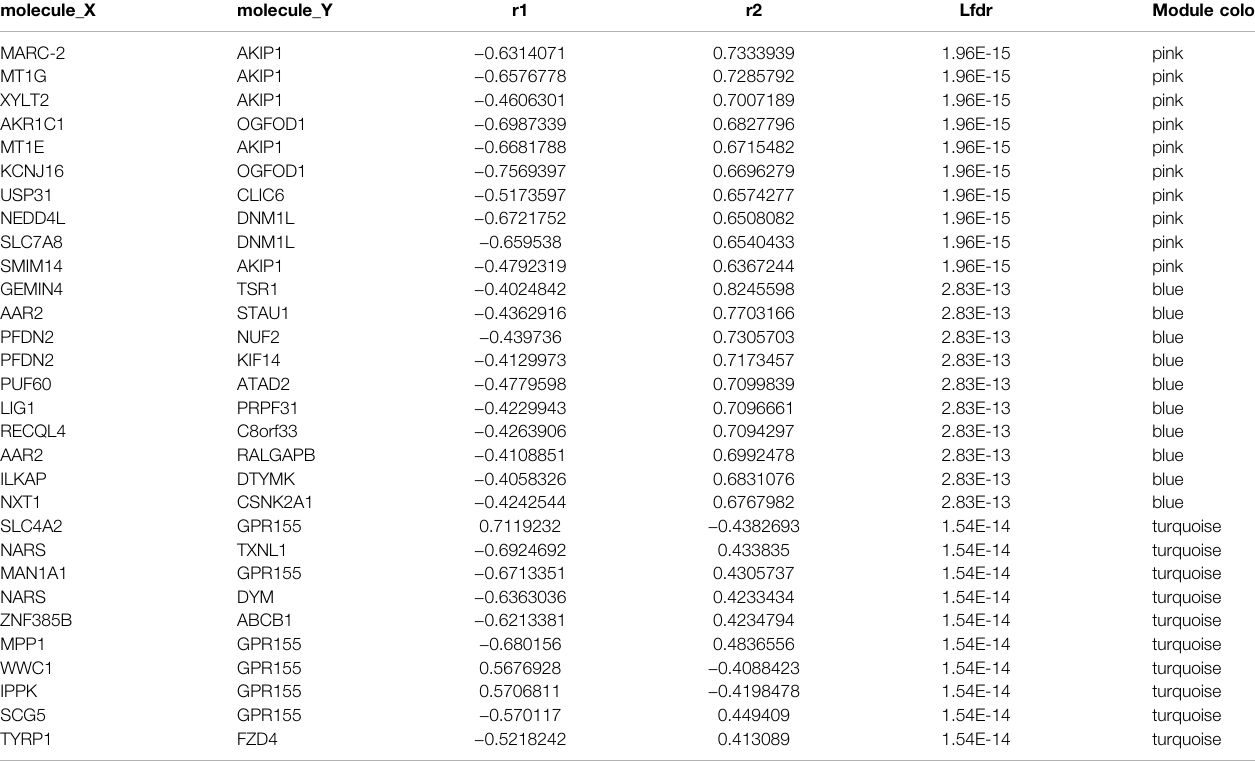
TABLE 1 | Top 10 correlated gene pairs changed to the opposite direction in each module between normal and GC samples.